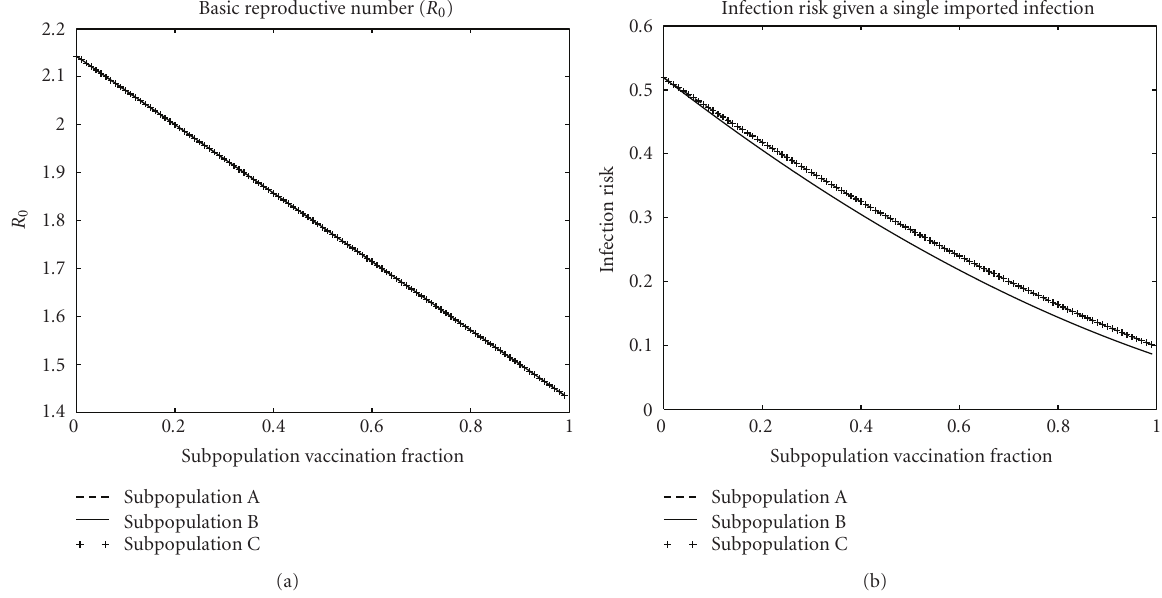
Figure 6: E ff ects of vaccination on R 0 and the risk of infection given a single randomly chosen initial infection (the probability of a major epidemic times the attack rate) in the mass-action models from Section 4.1. Though all three vaccination strategies have the same e ff ect on R 0 , vaccinating subpopulation B is optimal for reducing the overall risk of